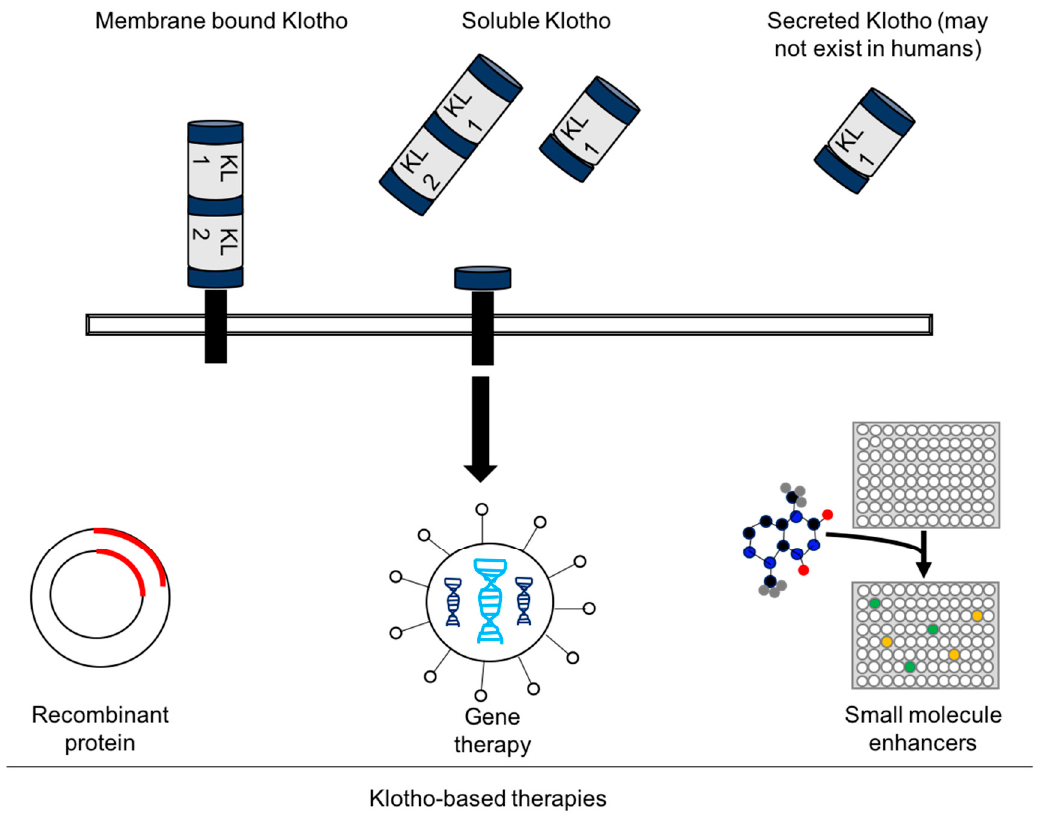
Figure 2. Potential delivery modalities of Klotho-based therapies. Full-length transmembrane Klotho is a ~135 kDa protein. Cleavage of full-length Klotho by membrane proteases (ADAM10 and ADAM17) in an α -cut generates a 130 kDa soluble isoform containing the KL1 and KL2 domains. Cleavage in a β -cut generates a 65 KDa isoform that contains only the KL1 domain. Recent evidence has challenged the existent of secreted Klotho by alternative splicing of Klotho mRNA. Various Klotho-based delivery strategies have been explored as illustrated.